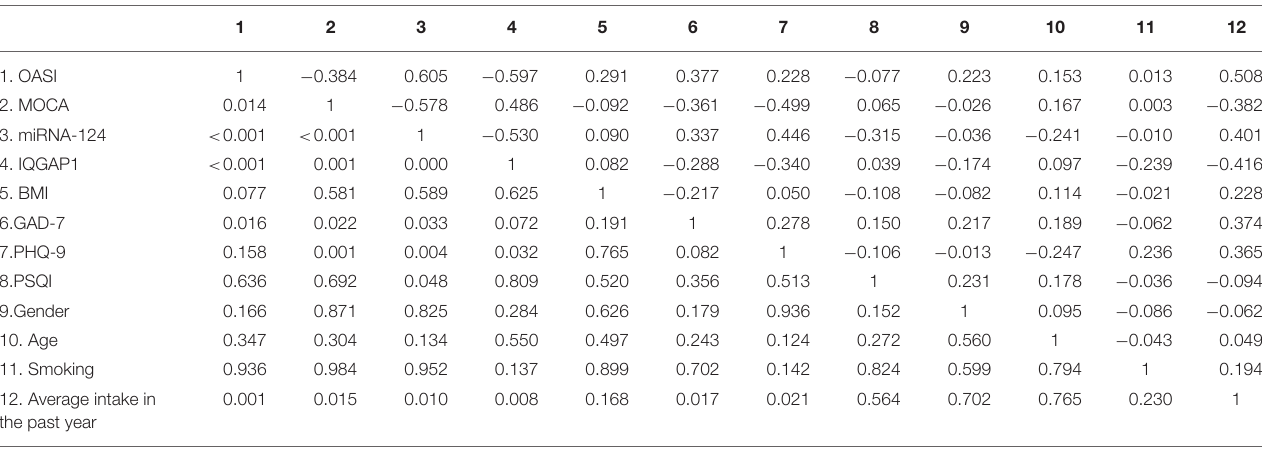
TABLE 2 | Correlation analysis of OASI and MOCA total score in morphine-dependent patients a